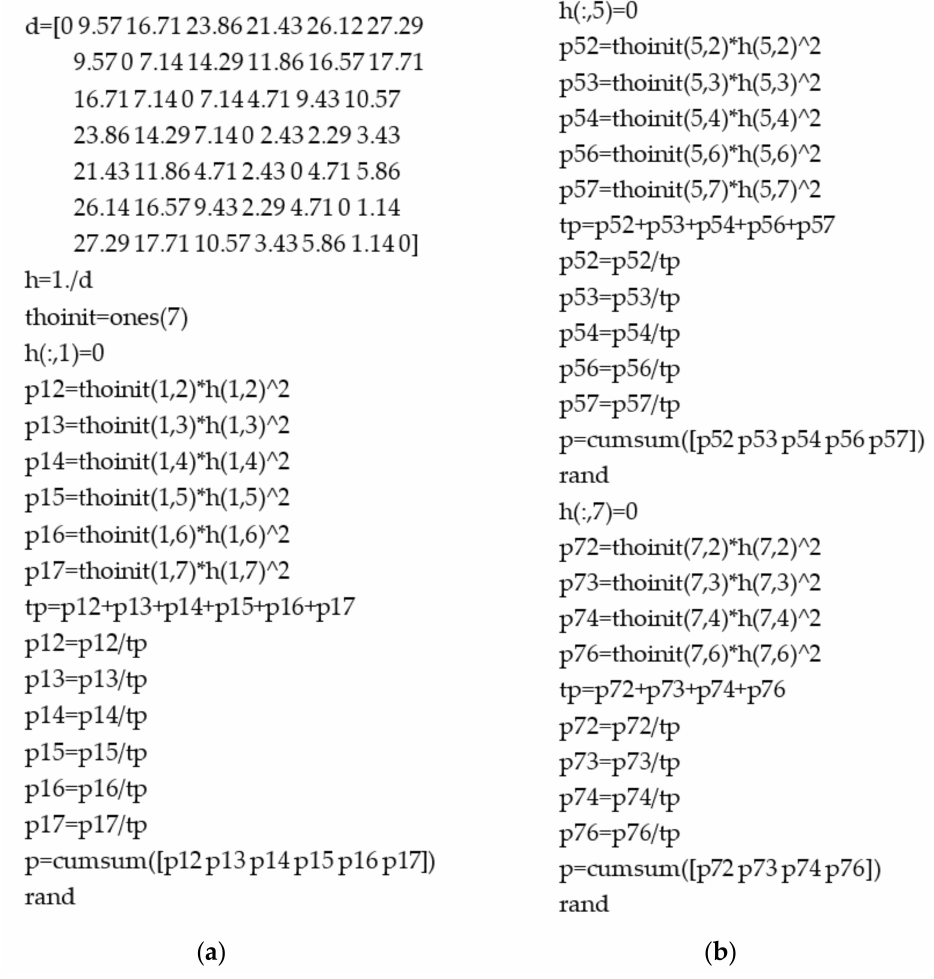
Figure 4. Fragment of algorithm initiated in MATLAB program for PV criterion: ( a ) first part, ( b ) second part.